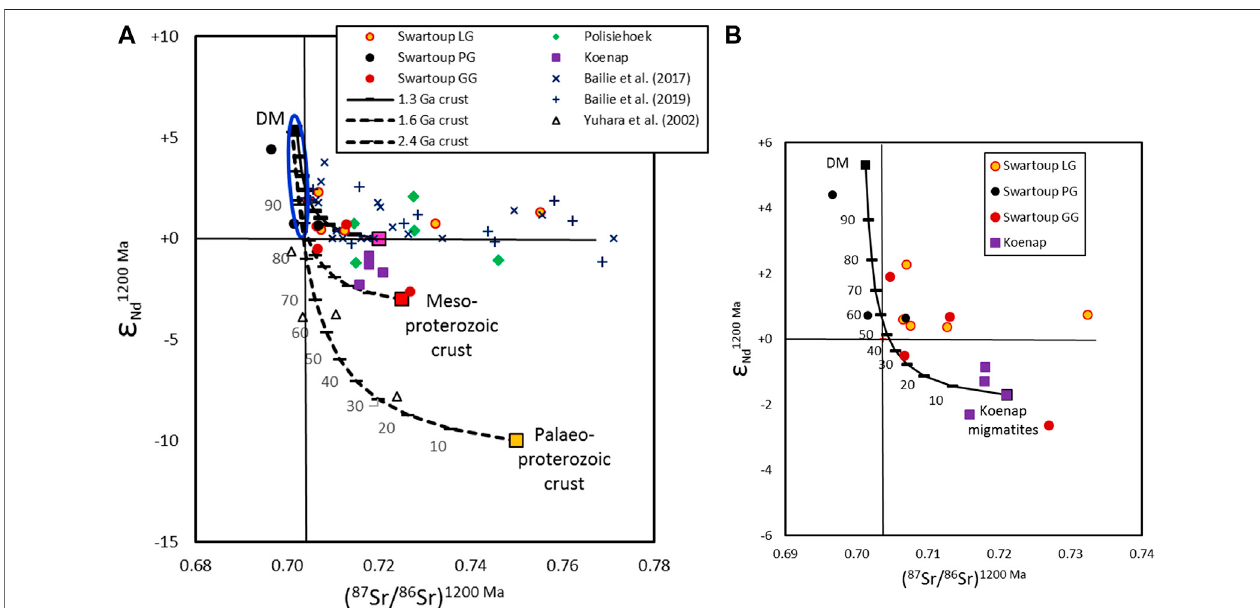
FIGURE 9 | Initial Sr and Nd isotopic compositions, corrected to 1,200 Ma, the approximate age of the Polisiehoek granite emplacement. Bulk Earth composition indicated by black lines. (A) Approximate positions for the depleted mantle (DM, in the blue ellipse), and Mesoproterozoic (1.3 Ga, magenta square; 1.6 Ga red square) andPaleoproterozoic(1.9 Ga;orangesquare)crustalrocks.Mixingmodelscorrespondingtoadditionofamantle-derivedend-membertocrustalreservoirsof ∼ 1.3,1.6, and a 2.4 Ga ages are indicated by the graduated curves. In (B) , the mixing of Koenap sample 1147B, compositions with depleted mantle is modeled with referencetotheSwartoupgranitoidsamples.DataforBulkEarthfromMcCullochandWasserburg(1978),depletedmantlefromDePaolo(1981)andFaure(1986)forNd andSr,respectively.RegionalcrustalreservoircompositionsarebasedonNamaquaProvincedatasetsfromYuharaetal.(2002),Eglington(2006),andBailieetal.(2017)